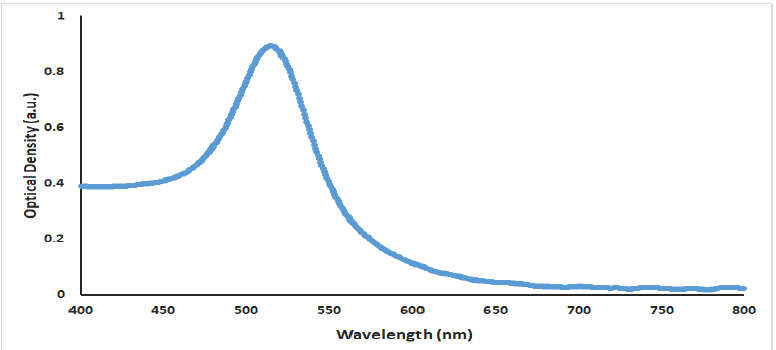
Figure 3. Quadratic electro-optic modulation data for different applied electric fields, for a particle diameter of about 50 nm.